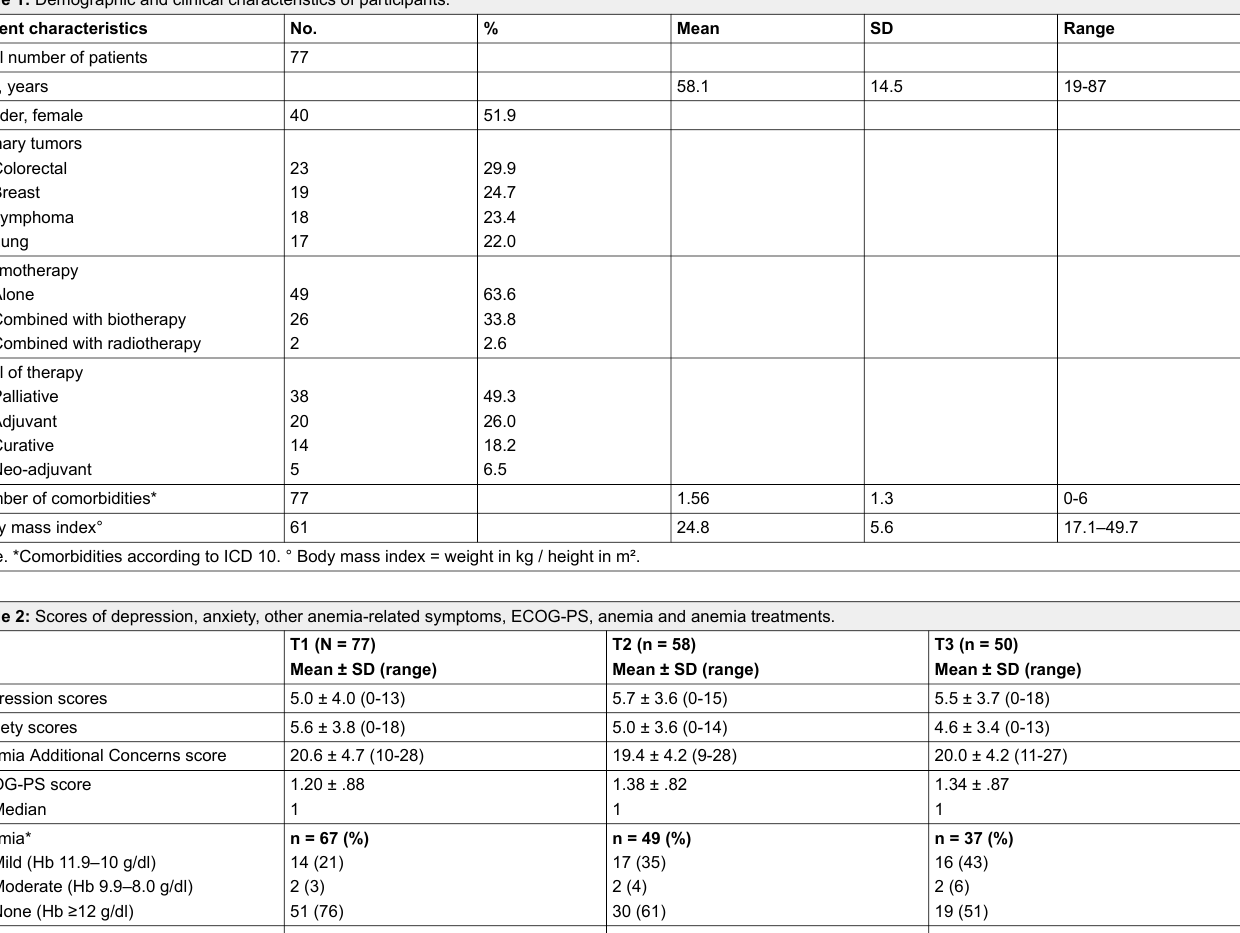
T2 (n = 58) Mean ± SD